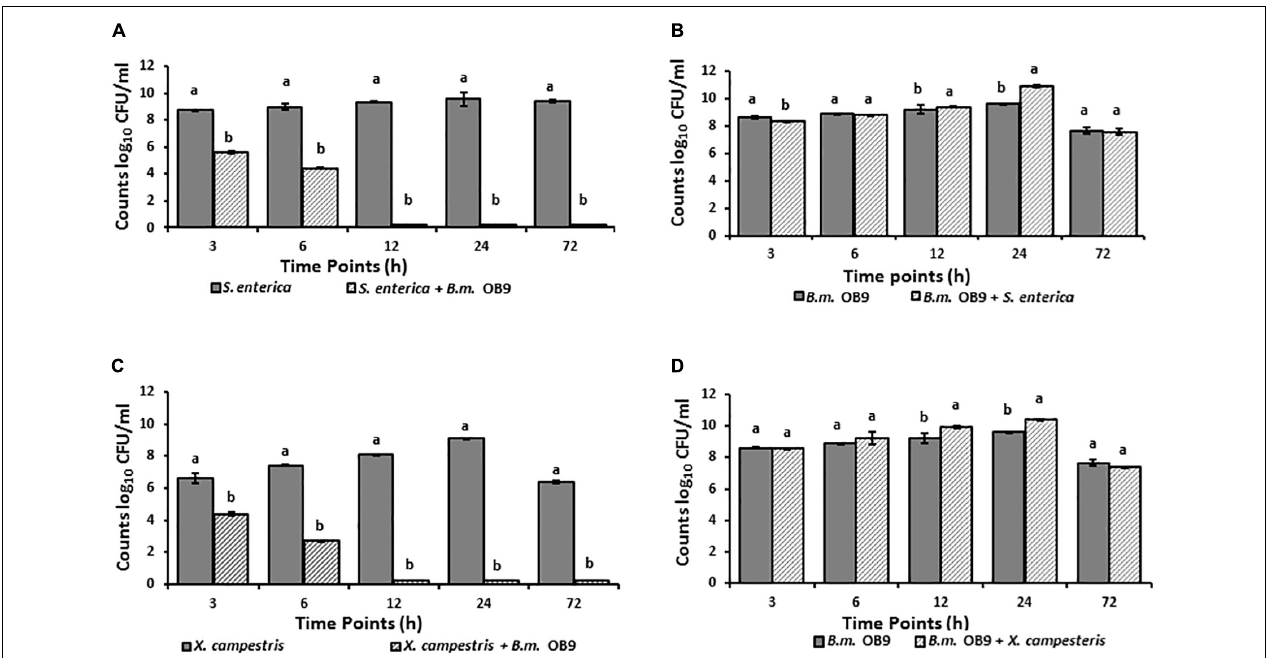
FIGURE 5 | Suppression of Salmonella and Xanthomonas growth in co-cultures with B. methylotrophicus OB9. Temporal microbial counts of S. enterica Newport (SL1) (A) and B. methylotrophicus ( B.m .OB9) (B) in single culture and co-cultures over 72 h. Temporal microbial counts of Xanthomonas (C) and B. methylotrophicus OB9 (D) in single culture and co-culture over 72